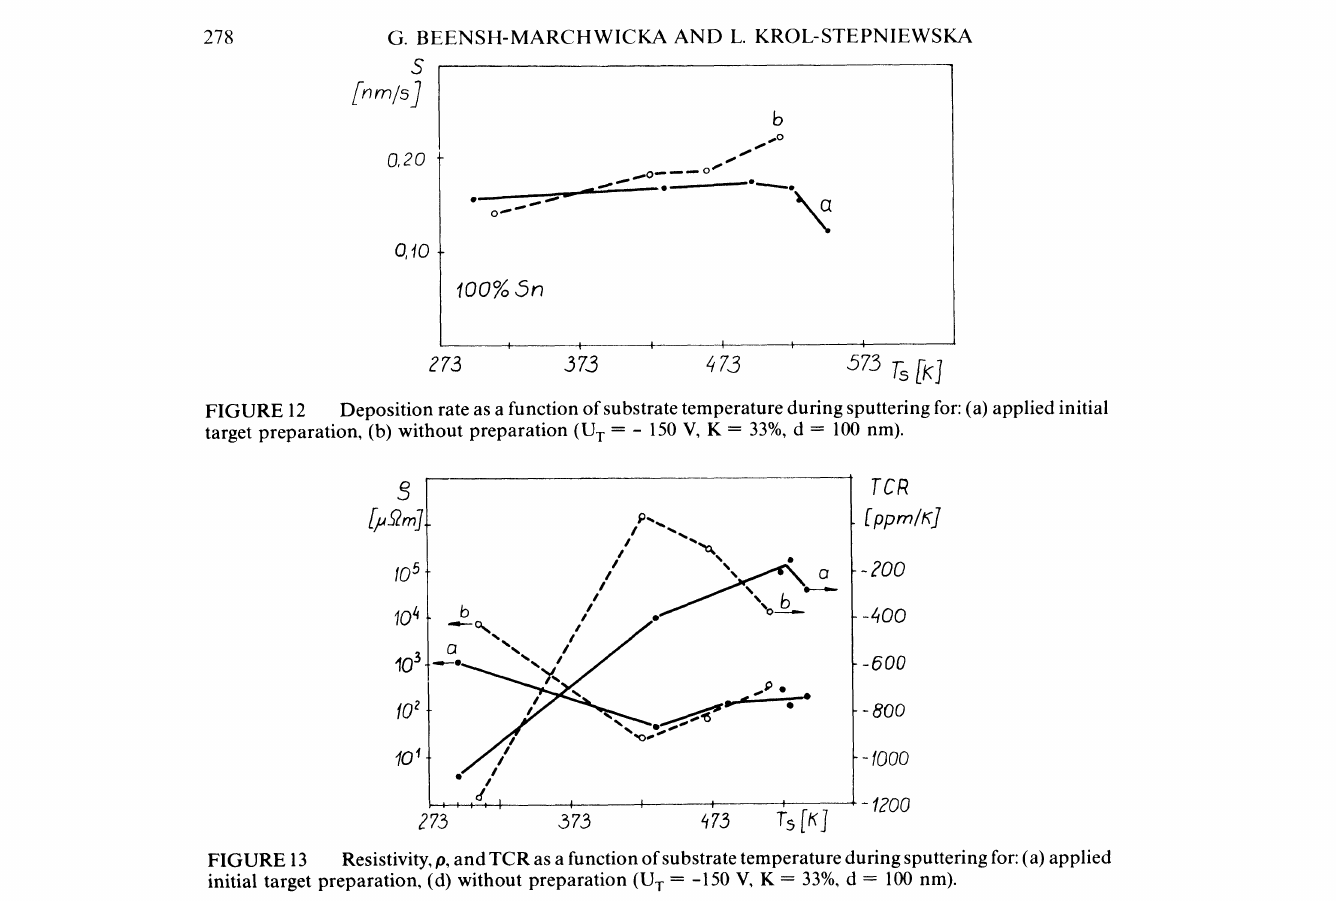
Resistivity, p, and TCR as a function ofsubstrate temperature during sputtering for: (a) applied initial target preparation, (d) without preparation (U T -150 V, K 33%, d 100